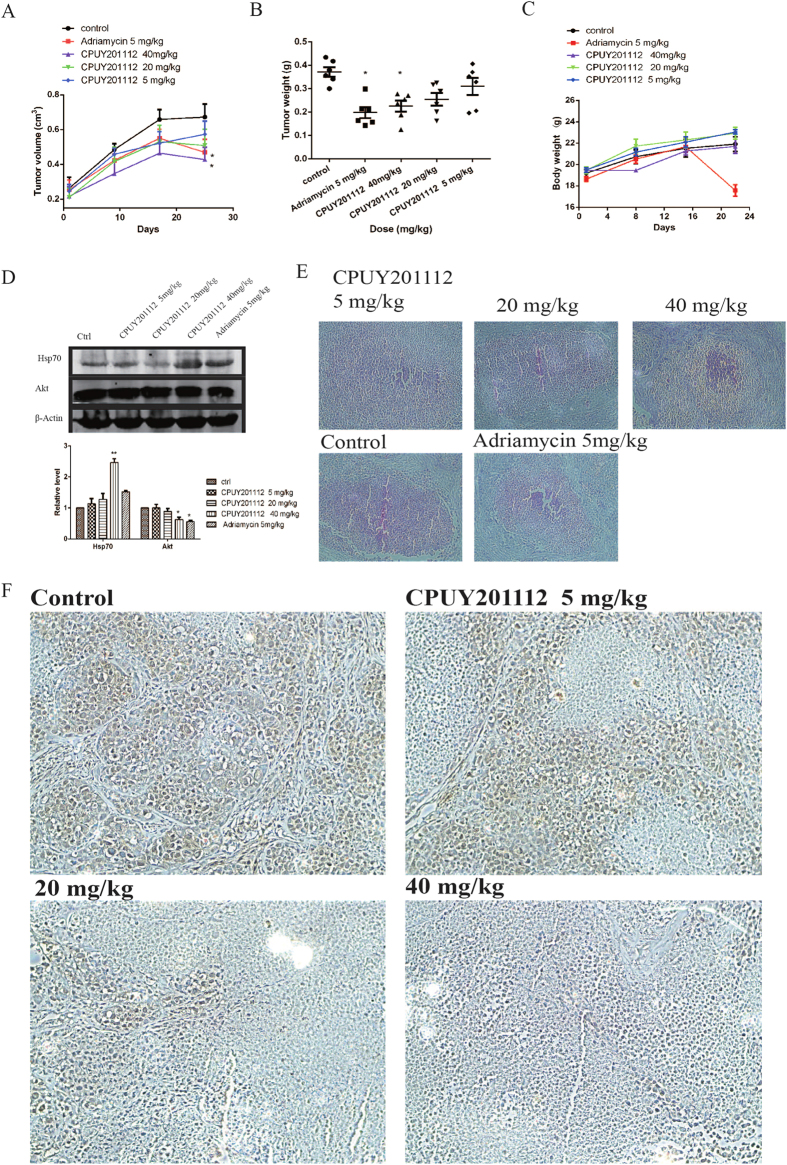
CPUY201112 inhibits the growth of MCF-7 xenografts in nude mice.(A–C) Female nude mice implanted with MCF-7 xenografts were treated with 5 mg/kg or 10 mg/kg of CPUY201112 for 24 days. Tumor diameters were measured and used to calculate tumor volumes (A). After 24 days, the mice were sacrificed, and individual tumors were weighed (B). *p < 0.05, student t-test (n = 6). (D) Western blot analysis of Hsp70 and Akt in the tumor. *p < 0.05; **p < 0.01; Student t-test (n = 3). The blots are cropped and the gel were run under the same condition. (E) Representative H&E images of individual tumors. (F) Immunohistochemical evaluation to assess HER-2 levels in MCF-7 tumor tissue after treatment with CPUY201112.